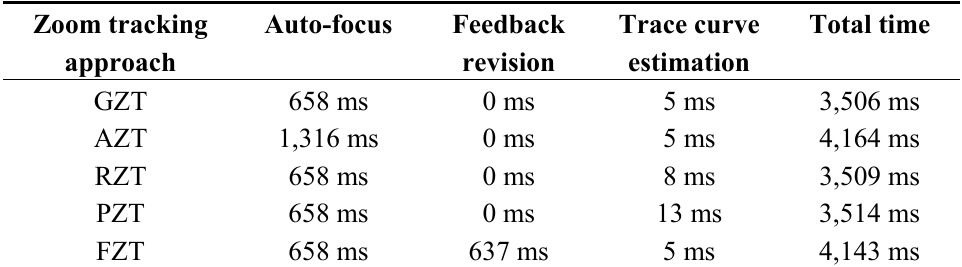
Table 6. Time consumption of zoom tracking